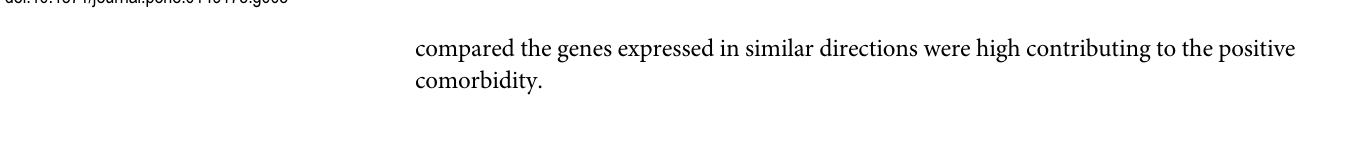
Fig 5. Psoriasis diseaseome enclosing the protein contributors from obesity. Pink nodes — proteins involved in psoriasis, red nodes — common proteins shared by obesity and psoriasis and blue nodes indicate indirect